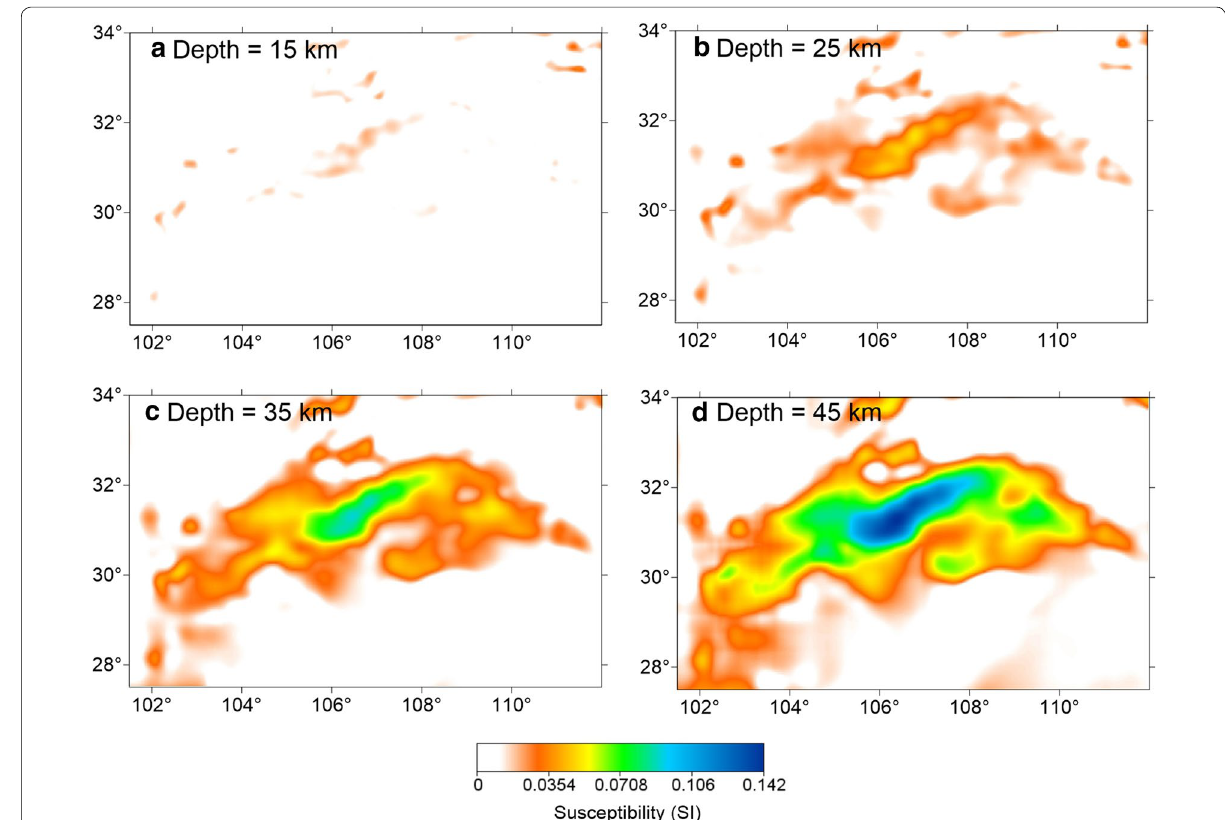
Fig. 4 Horizontal slices of the inverted susceptibility model at different depths. a The slice at depth slice at depth 35 km. d The slice at depth =